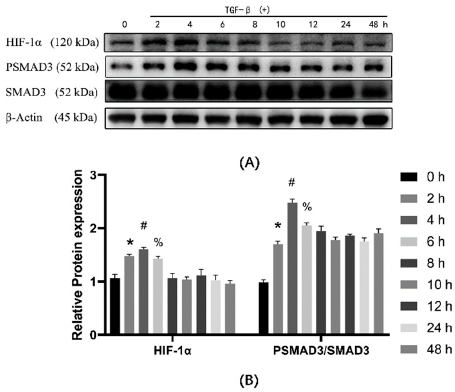
Figure 3. The effect of TGF- β 1 on cell transdifferentiation was analyzed by comparing the expression of HIF-1 α , SMAD3, and PSMAD3 using TGF- β 1-treated cells. ( A ) Western blot analysis of HIF-1 α , SMAD3, and PSMAD3 in cells of different groups. β -actin was used as a loading control. ( B ) Quantitative analysis of HIF-1 α , PSMAD3/SMAD3 is shown in Figure 3A. * p < 0.05 vs. 0 h group; # p < 0.05 vs. 2 h group; % p < 0.05 vs. 4 h group. ANOVA was used to compare multiple groups and pairwise comparisons were compared by LSD-t test. A value of p < 0.05 was considered to be statis-